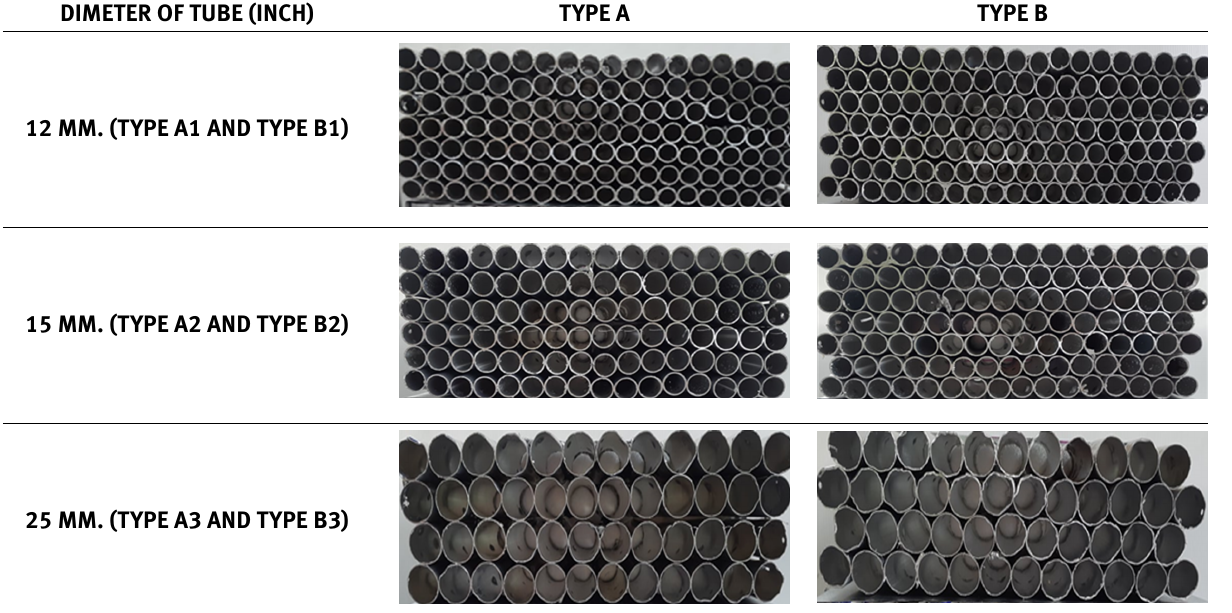
Table 1: Characteristics of circular honeycomb core with square structure (Type A) and circular honeycomb core with star structure (Type B) DIMETER OF TUBE